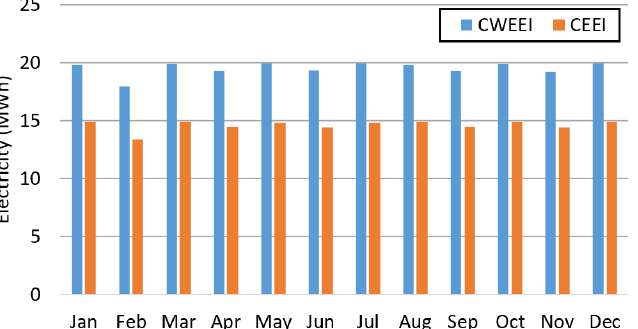
Figure 6. Electricity production from diesel generator in year 15 for the CWEEI and the